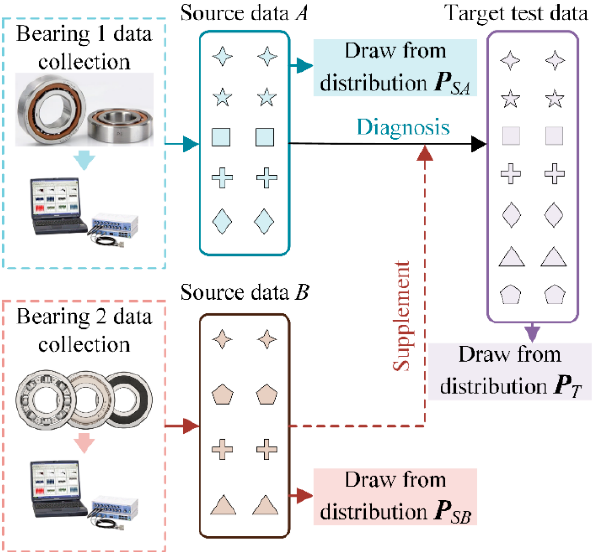
Figure 1. Example of the situation of fault diagnosis with new health states.